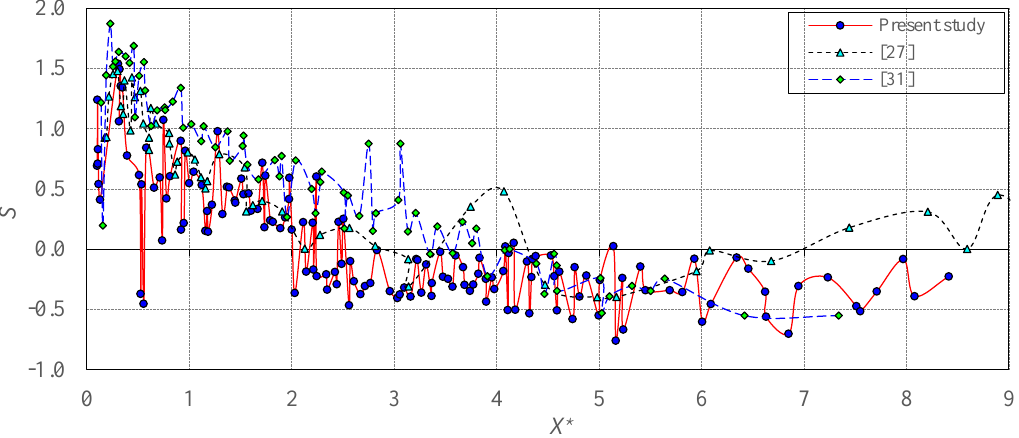
Figure 4. Skewness coefficient along the stilling basin.